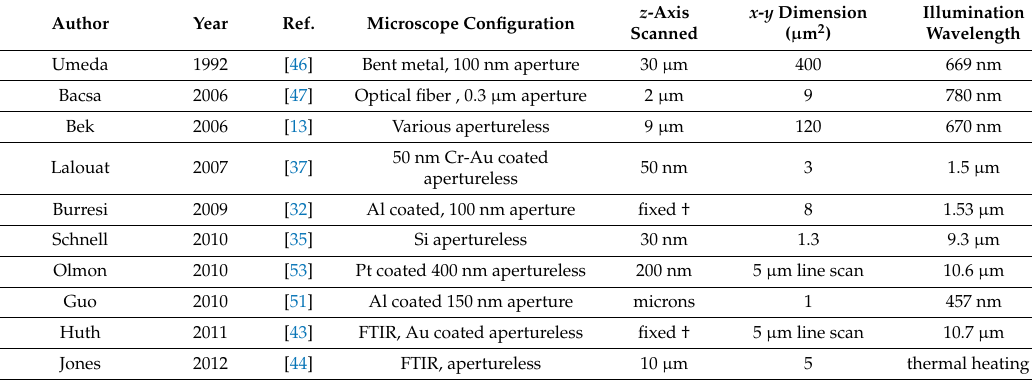
Table 1. Configuration of SNOM instruments reported in the literature.